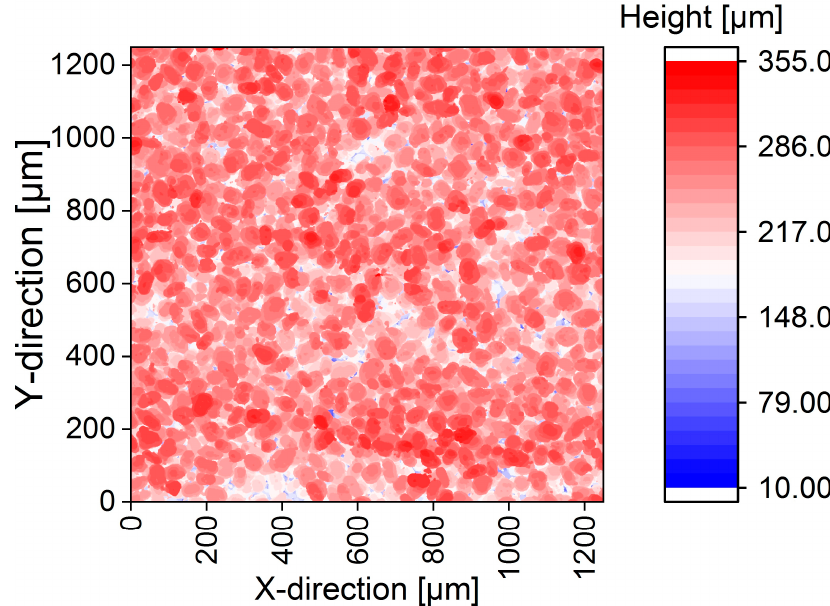
Figure A2. Topology of a powder bed (flat blade, PA Original) measured with